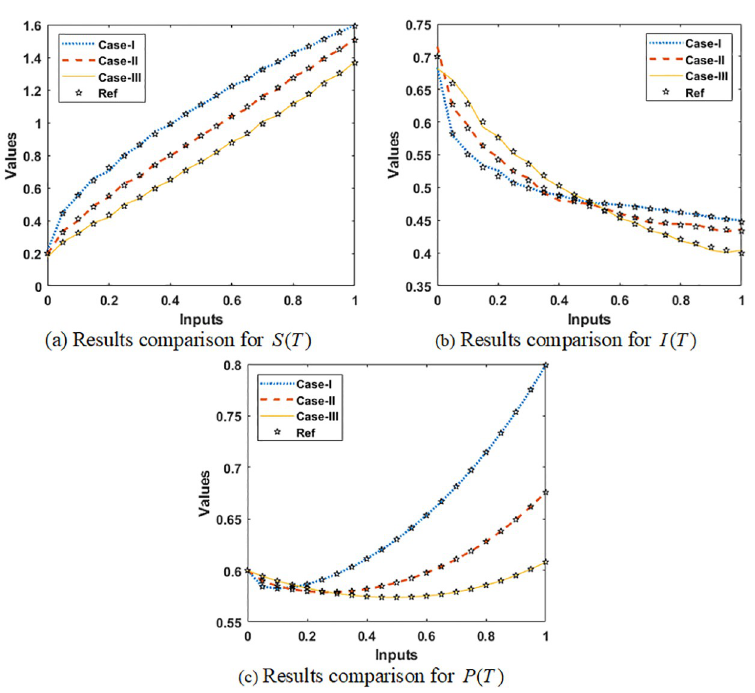
Fig 9. Result comparison illustrations for solving the infection FONPPS. (a) Results comparison for S ( T ) (b) Results comparison for I ( T ) (c) Results comparison for P ( T ).